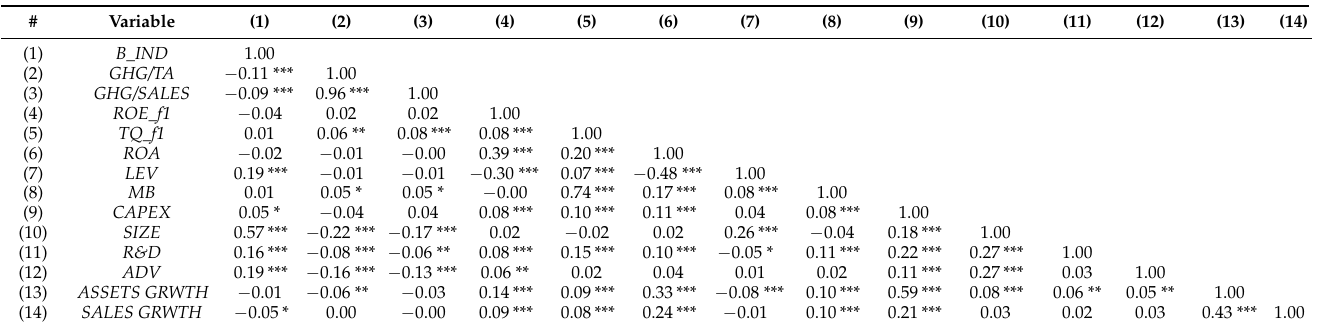
Table 2. Correlation Matrix.